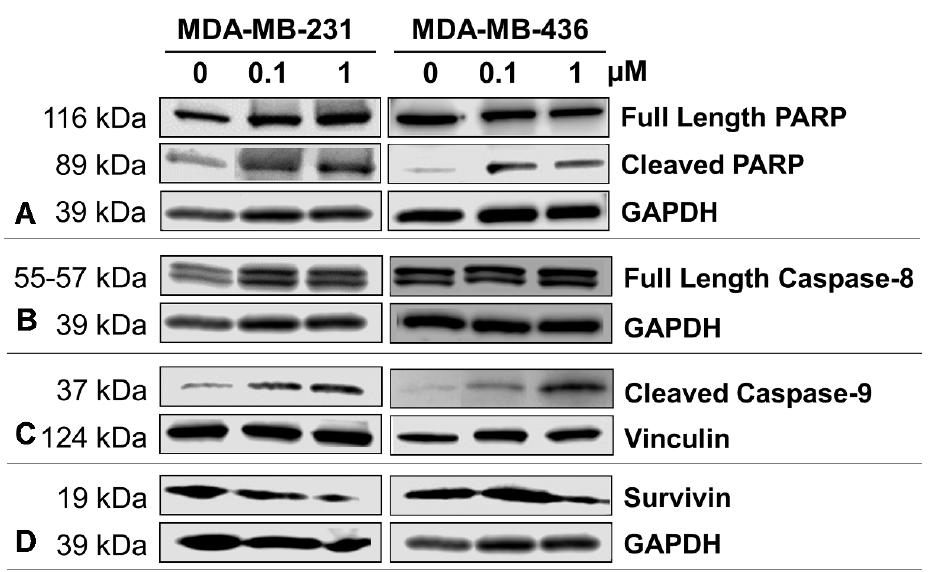
Figure 6. Western blot analysis and densitometry measurements of treated TNBC cell lines with arachidin-1 (A-1, 0.1, and 1 µM). Western blot images of ( A ) PARP and cleaved PARP, GAPDH loading control. ( B ) Full-length caspase-8, GAPDH loading control; ( C ) cleaved caspase-9, vinculin loading control; and ( D ) survivin, GAPDH loading control. Lysates (60 µg of total protein) of MDA- MB-231 and MDA-MB-436 cells treated with A-1 were analyzed by western blotting. The relative densitometry of ( E ) full-length PARP, ( F ) cleaved PARP, ( G ) caspase-8, ( H ) cleaved caspase-9, and ( I ) survivin protein levels were analyzed by comparing to the loading control. Cells with 0.01% DMSO were used as controls. Data represents mean ± SD from three or more independent experi- ments. * p < 0.05, ** p < 0.001, *** p < 0.0001, **** p < 0.0001 versus control in MDA-MB-231, # p < 0.05 ## p < 0.001, ### p < 0.0001, #### p < 0.00001 versus control in MDA-MB-436, and ns = not significant from control. 3. Discussion TNBC cancer consists of 10 to 15% of all breast cancer types and is an aggressive type of cancer due to its quick cell proliferation and metastasis [38]. Since hormonal and tar-